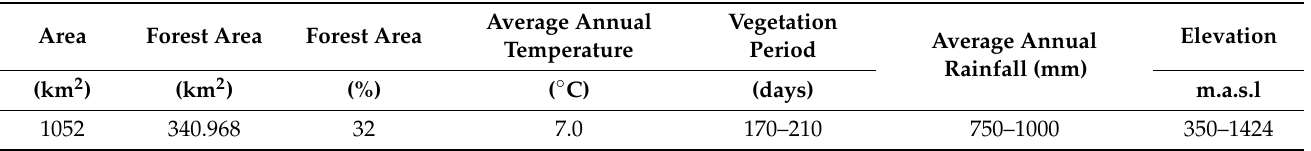
Table 1. Characteristics of the study area. The values were calculated on the basis of data from the publications of Zielony, Kliczkowska [26] and Kondracki